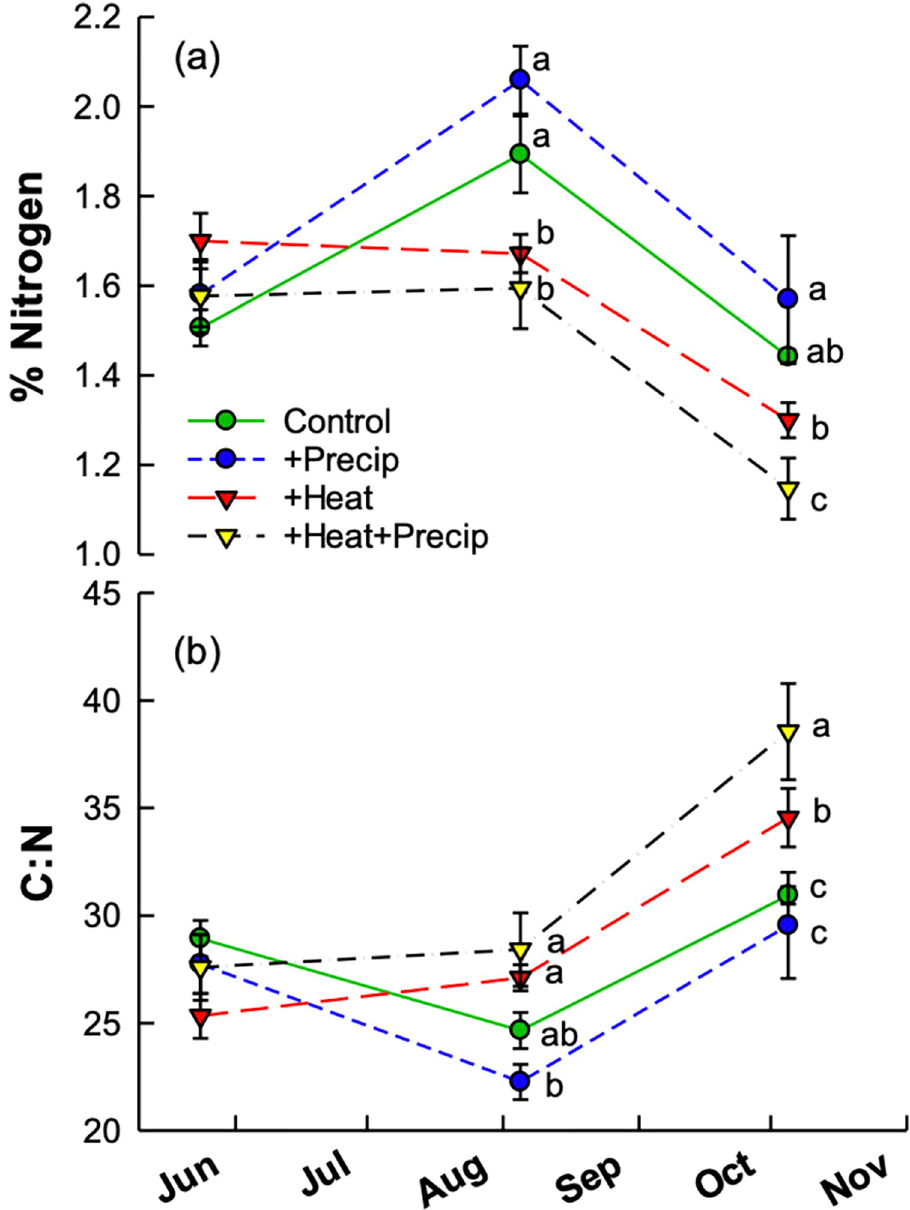
Fig 6. Average %N (a) and C:N (b) ( ± S.E.) of bulk forage harvested from the climate treatments over the 2013 growing season. Letters indicated significant differences within a given harvest date. There were no significant differences across climate treatments on the first harvest date. Fescue growing season was March 15-October 15 with harvests occurring mid-May, early August, and mid-October. Seasons are defined as: winter—December-February, spring—March-May, summer—June-August, and